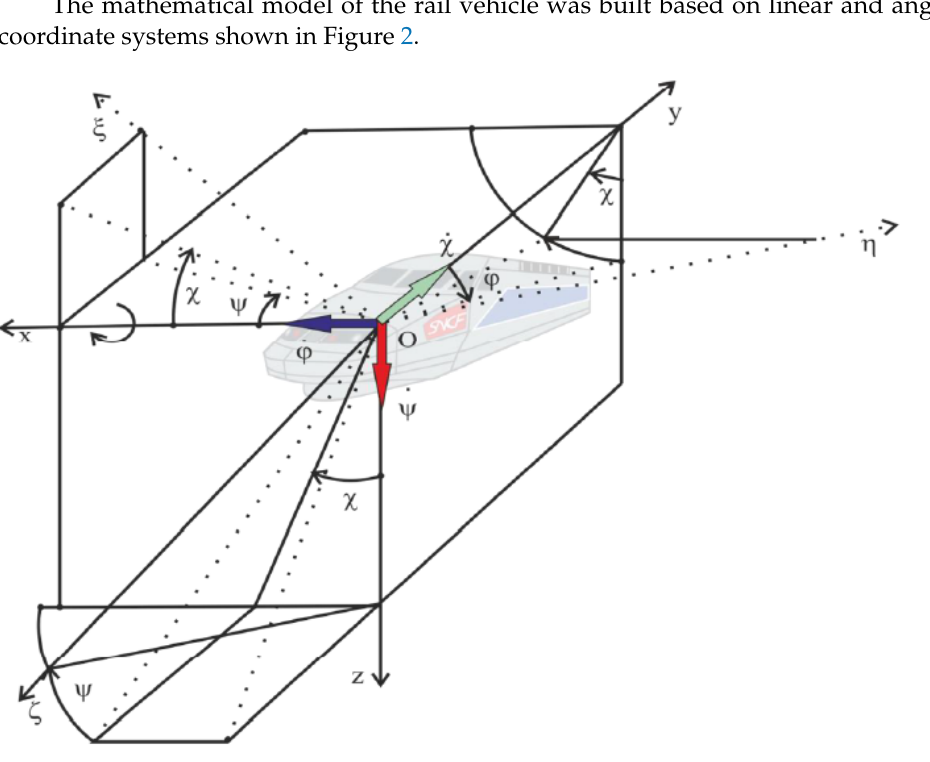
Figure 2. Linear and angular coordinate Figure 2 . Linear and angular coordinate system .